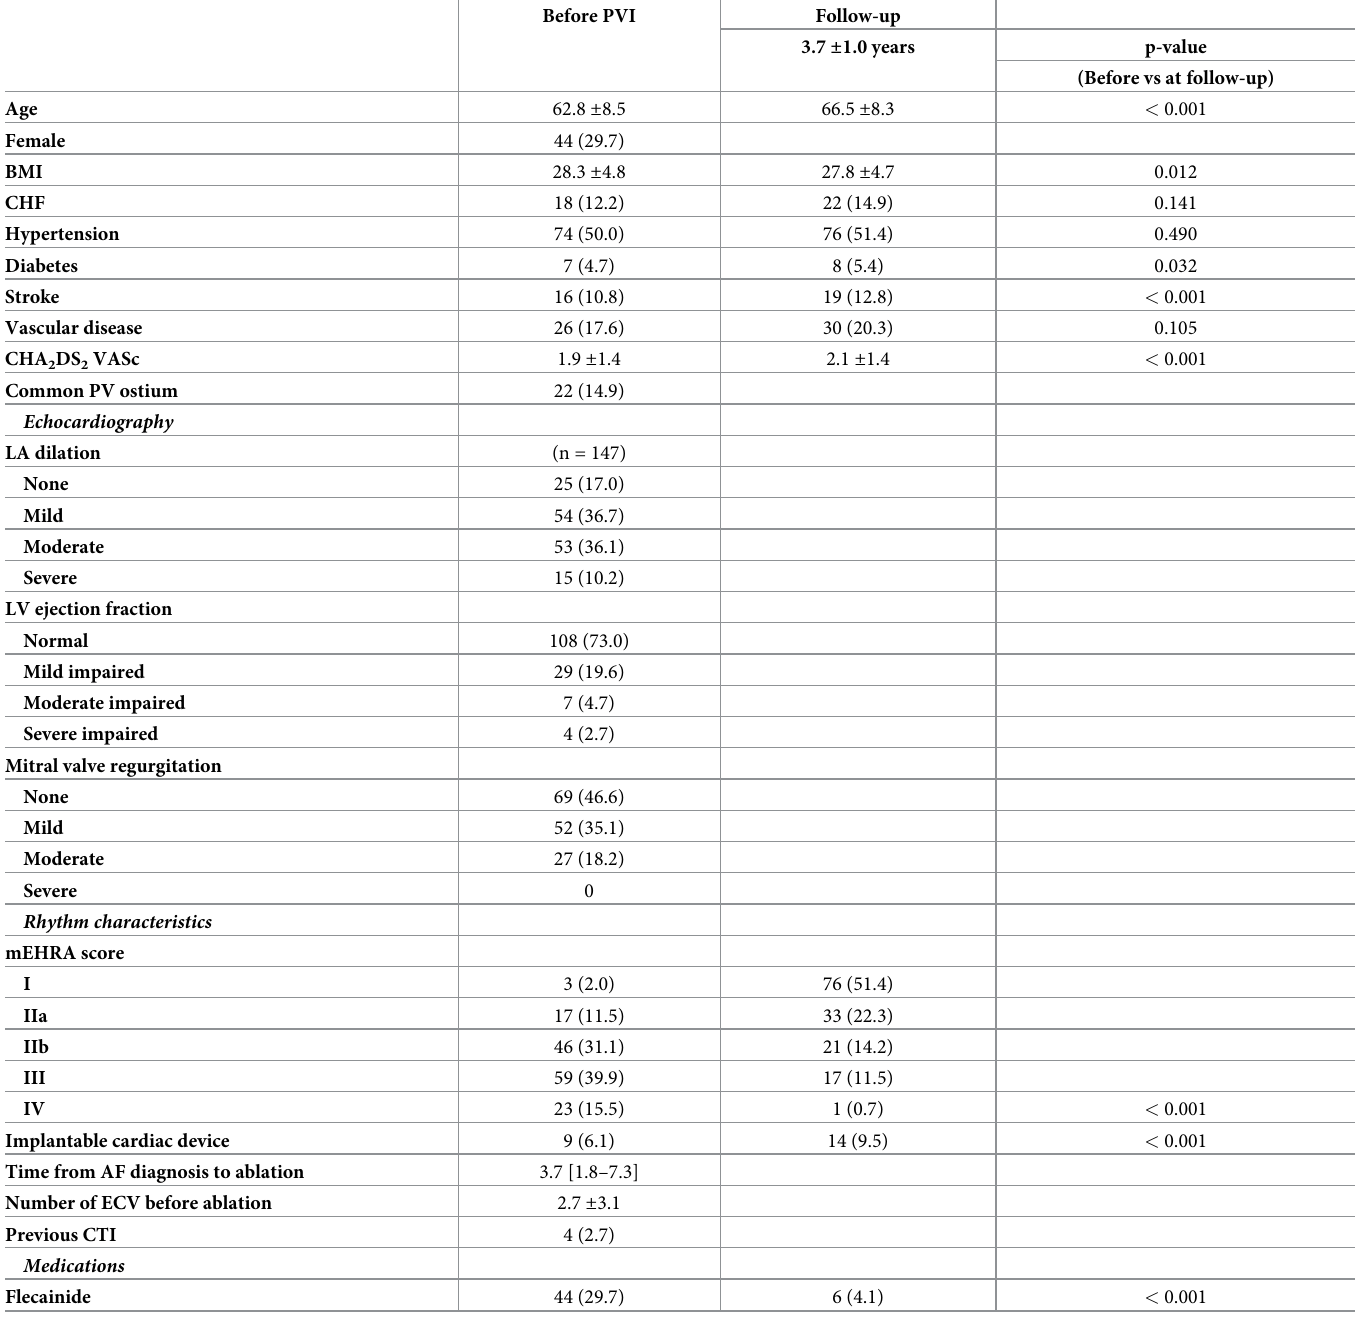
Table 1. Baseline characteristics of